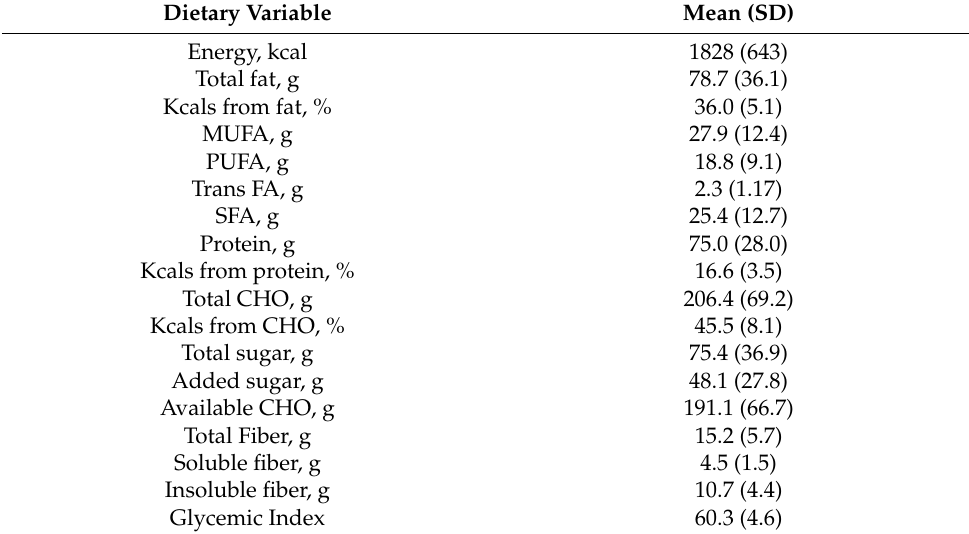
Table 2. Mean 10-day nutrient